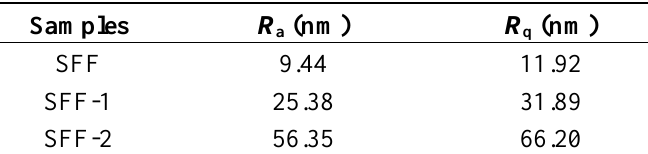
Table 2. Surface roughness values of untreated and modified silk fibroin fabrics determined from AFM